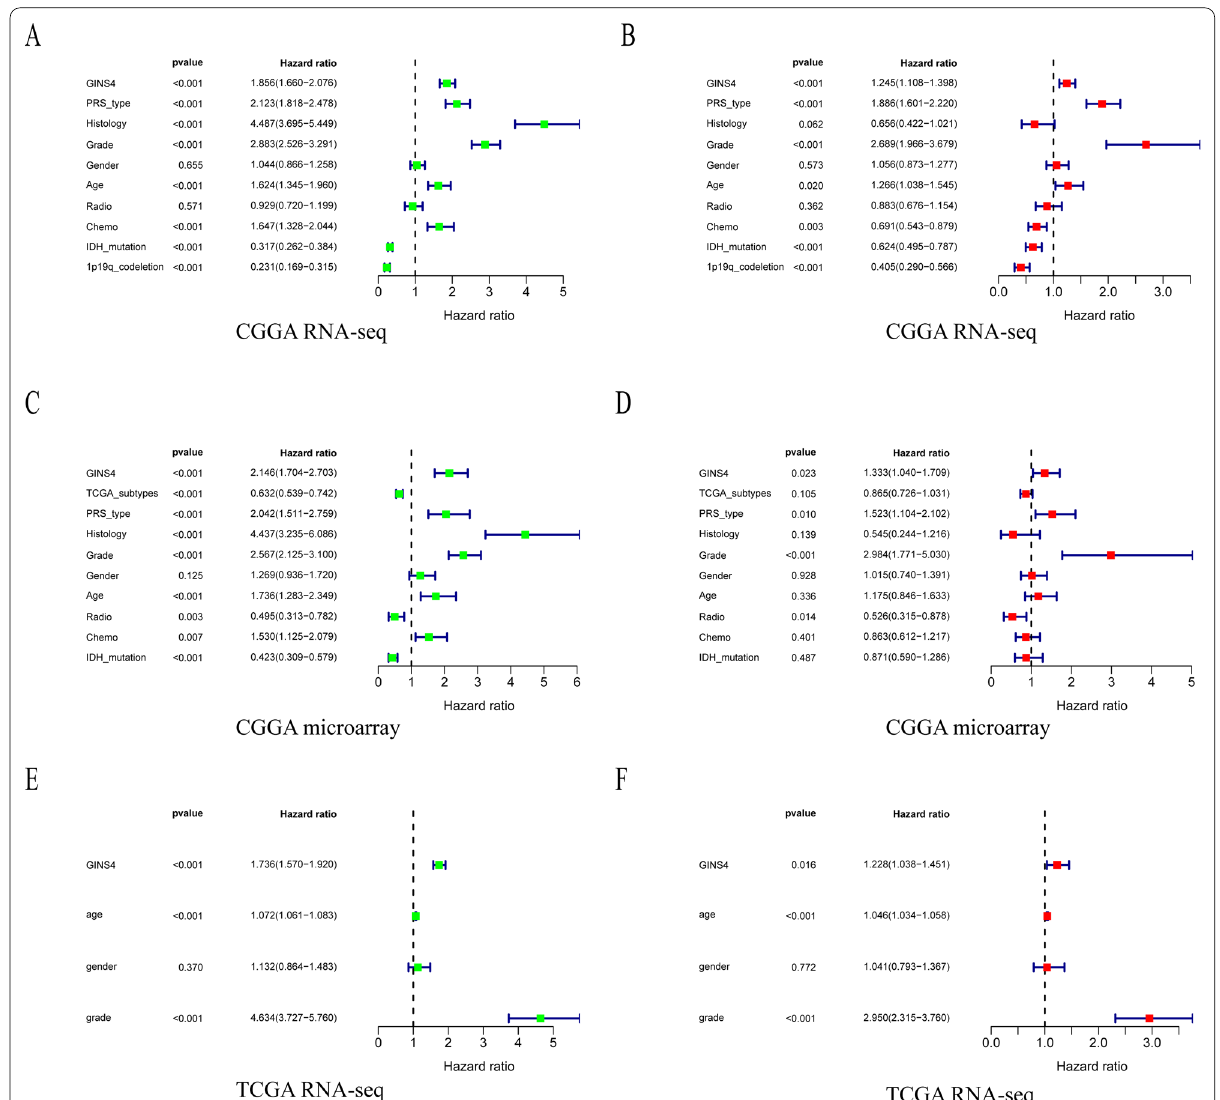
Fig. 5 GINS4 was an independent prognostic factor for glioma patients. A , C and E are univariate Cox analysis results base on CGGA RNA-seq, CGGA microarray, and TCGA RNA-seq datasets, respectively; B , D , and F are multivariate Cox analysis results base on CGGA RNA-seq, CGGA microarray, and TCGA RNA-seq datasets,